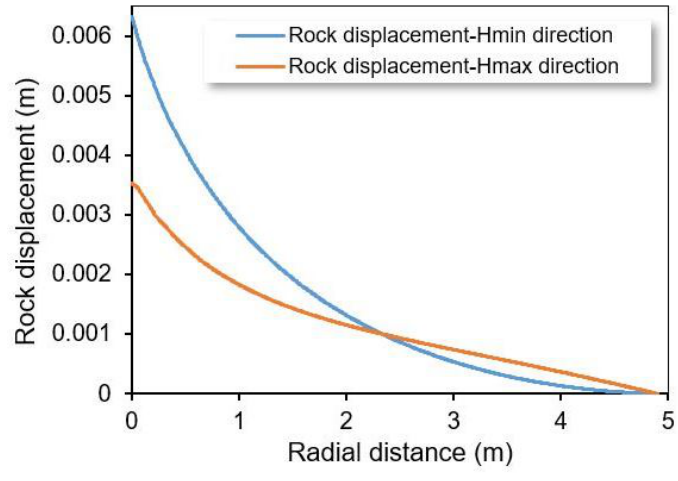
Figure 17. CSMP++ graphical plots of the rock displacement for a 2D chemo-thermo-poroelasticity steady-state